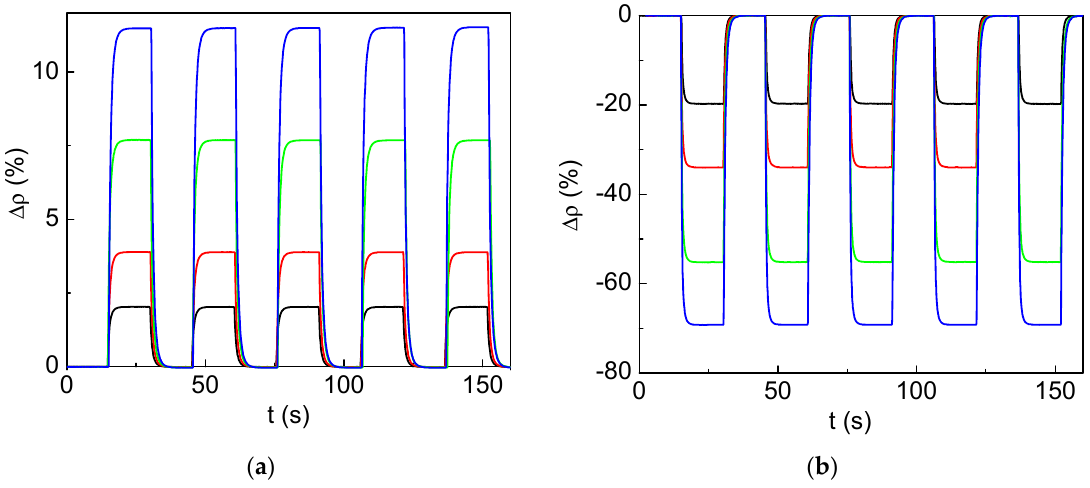
Figure 3. Percentage change of the resistivity for NNO films on ( a ) LSAT and ( b ) SiO 2 substrates at fixed temperature T = 26 °C and periodical 15-s illumination by the blue laser at different optical power: 0.2, 0.4, 0.8 and 1.2 W.